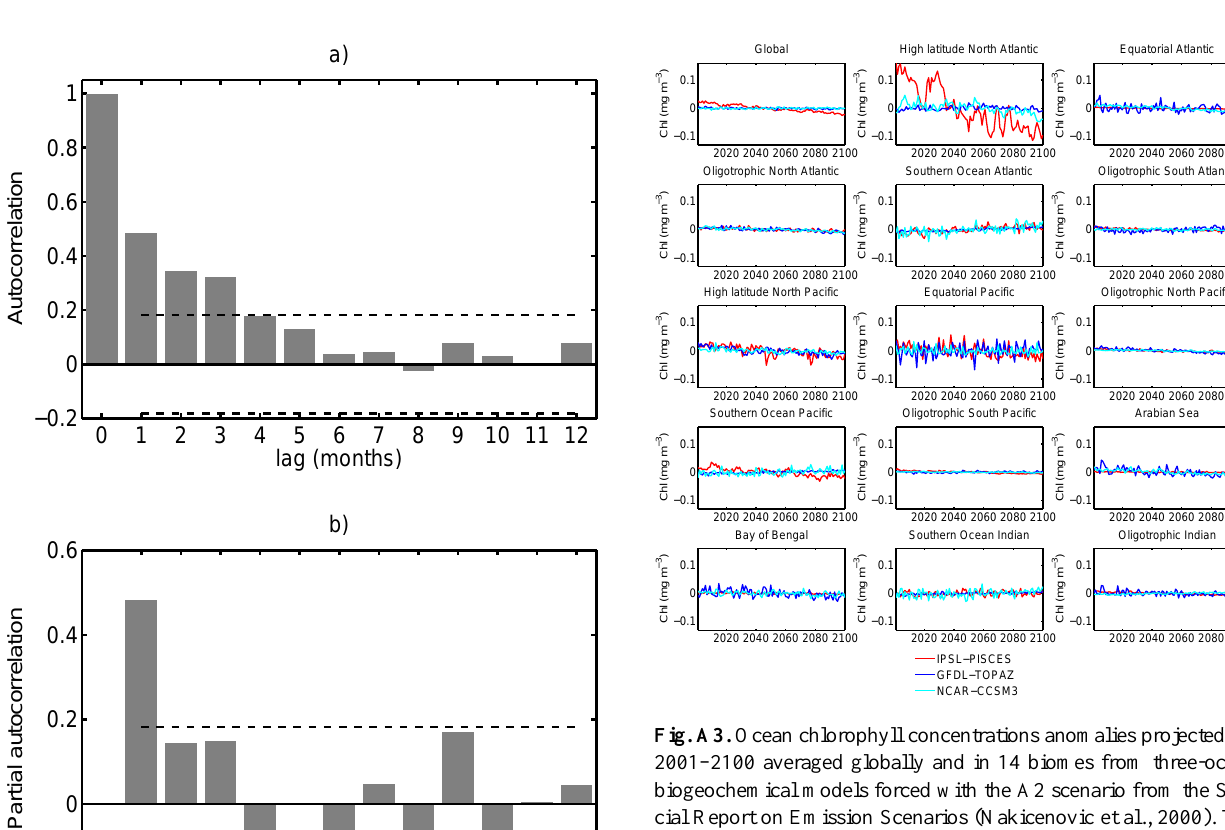
lantic, Southern Ocean Pacific, oligotrophic South Pacific, Arabian Sea, Bay of Bengal, Southern Ocean Indian and oligotrophic